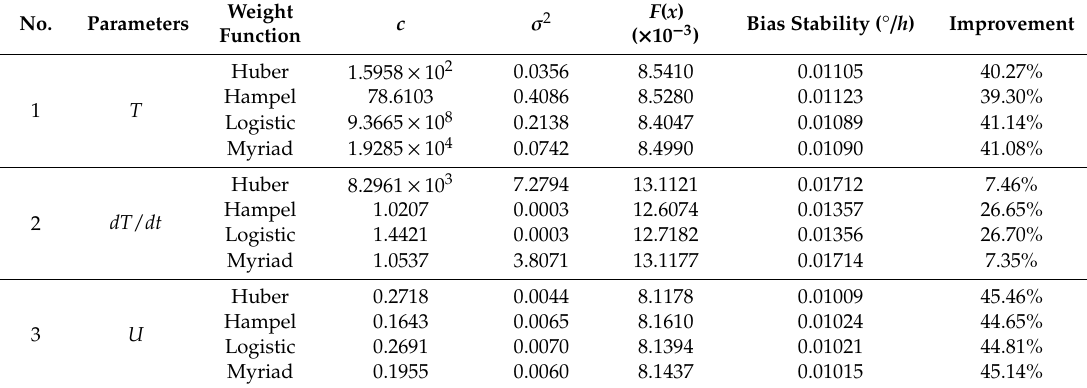
Table 4. TRPLG bias stability for compensated data based on IR-LSSVM model using di ff erent single parameters.